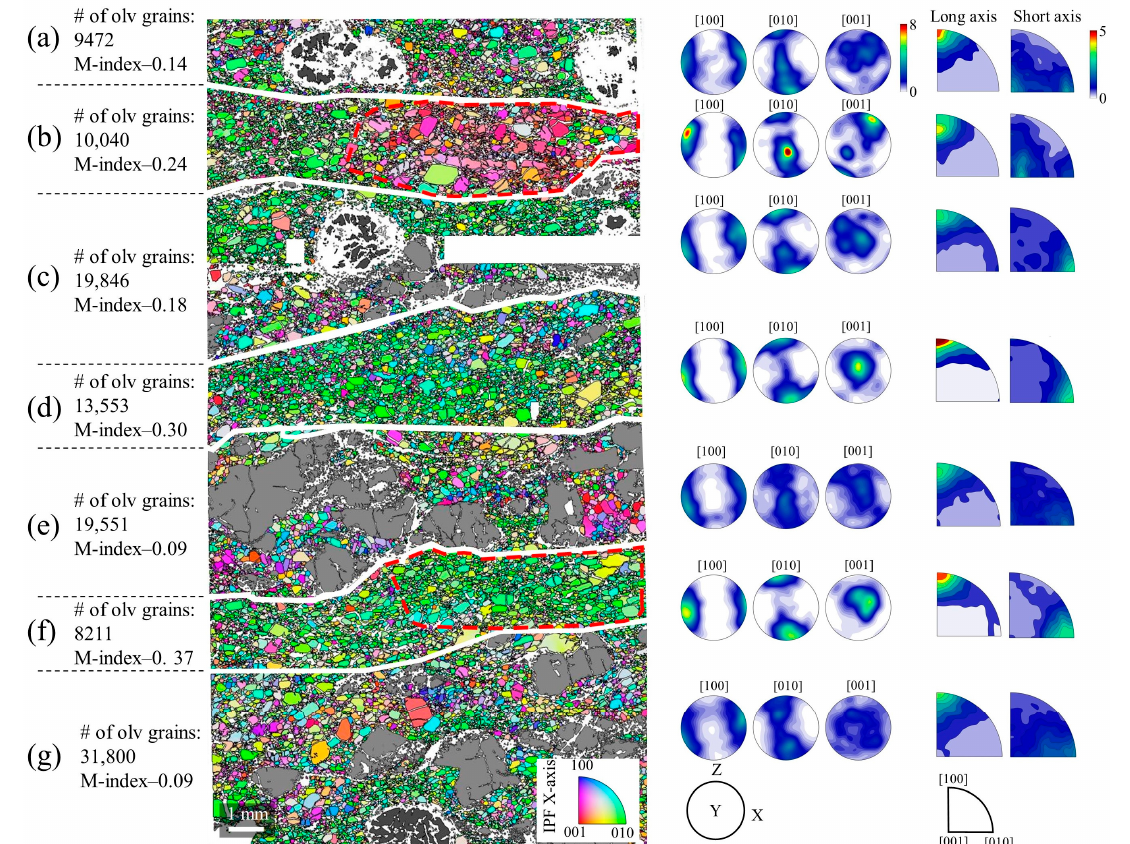
Figure 4. High resolution (3 μ m step size) orientation map used to characterize the different olivine monophase ( b , d , f ) and multiphase bands ( a , c , e , g ), delineated with white lines. Olivine crystallographic preferred orientations (CPO) of each band (area-weighted) are shown through pole figures. Olivine shape preferred orientations (SPO) of each band are shown through inverse pole figures for the long and short axes (left and right sides, respectively). The two red polygons delineate areas shown in Figure 7. Two white squared patches are due to an unfortunate glitch in scanning.